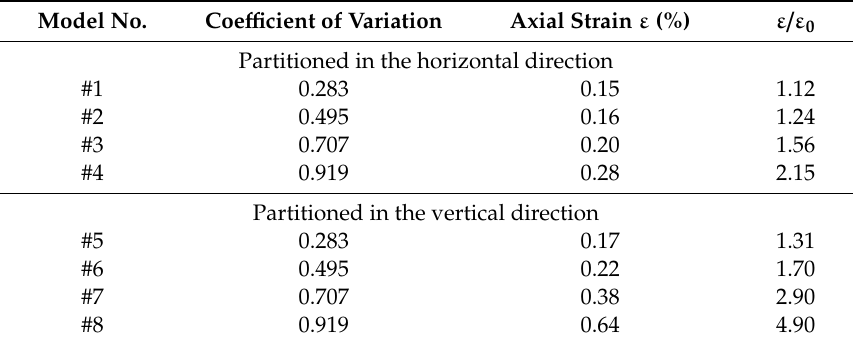
Figure 20. Axial strains with different coefficient of variation of aggregate distribution. Table 5. Axial strains when aggregates were distributed non-uniformly.